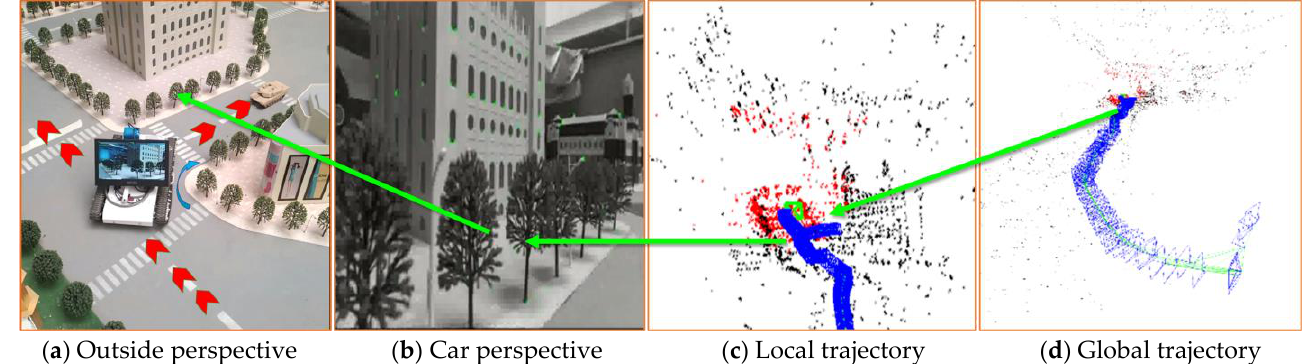
Figure 13. A real scene experiment of the SLAM system is proposed. The green arrow points to indicate the location of the turning intersection in different views. The red arrow indicates the direction of travel of the cart.